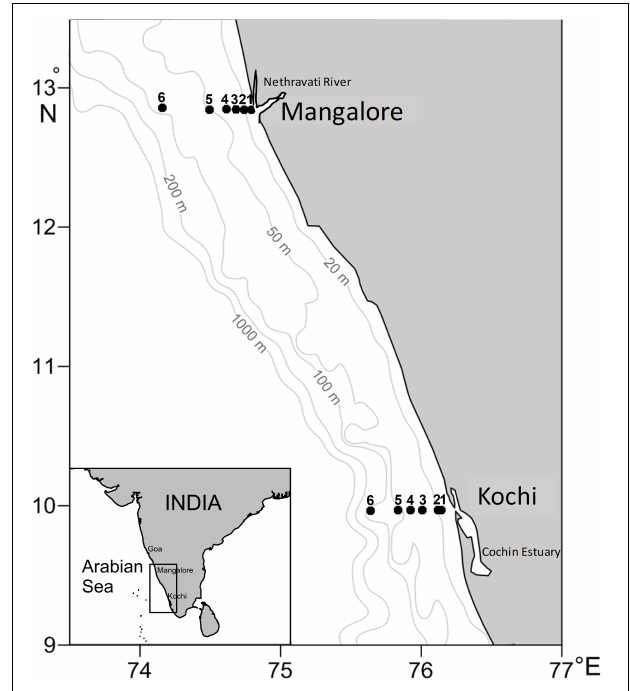
FIGURE 1 | Stations location